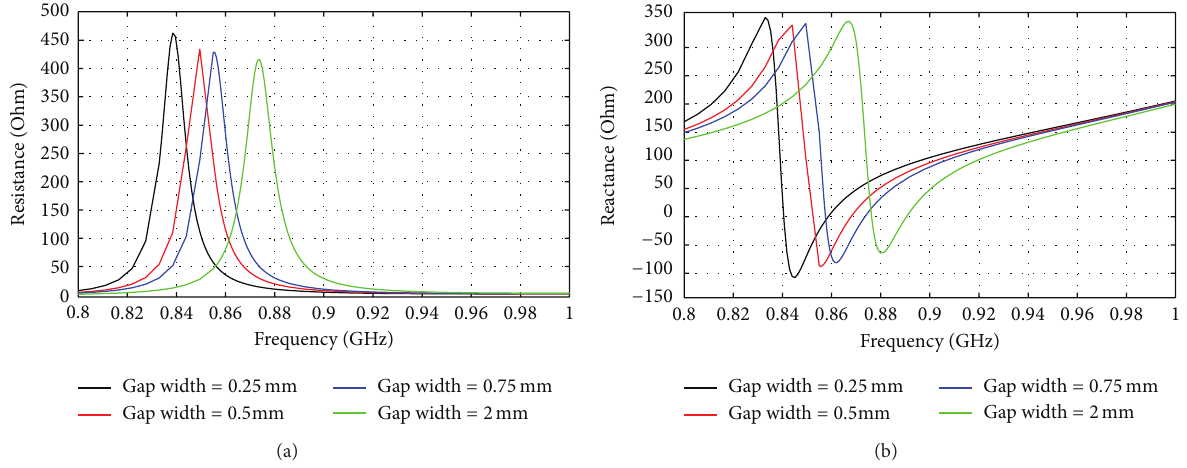
Figure 6: Tuning the real and imaginary parts of the input impedance by varying the width of the coupling